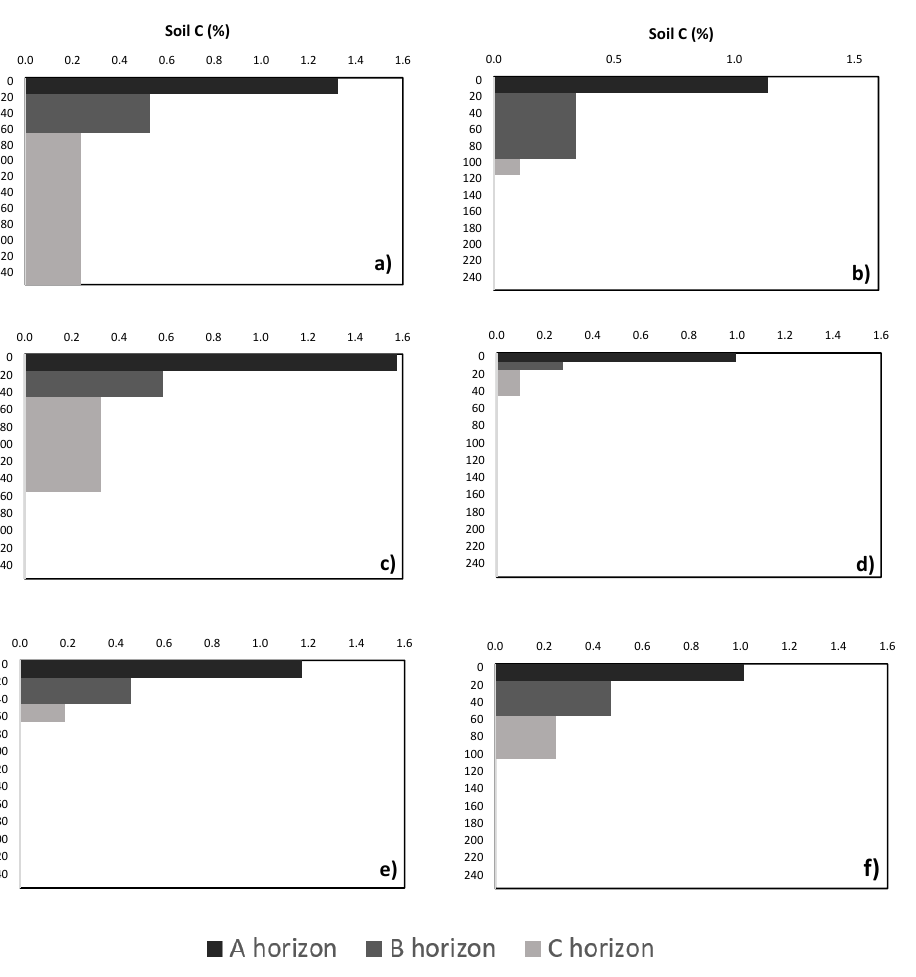
Figure 2. The vertical distribution of soil carbon within the ( a ) recharge (deep); ( b ) recharge (shallow); ( c ) responsive (saturated); ( d ) responsive (shallow); ( e ) interflow (A/B); and ( f ) interflow (soil/bedrock) soil profiles for the A, B, and C horizons.